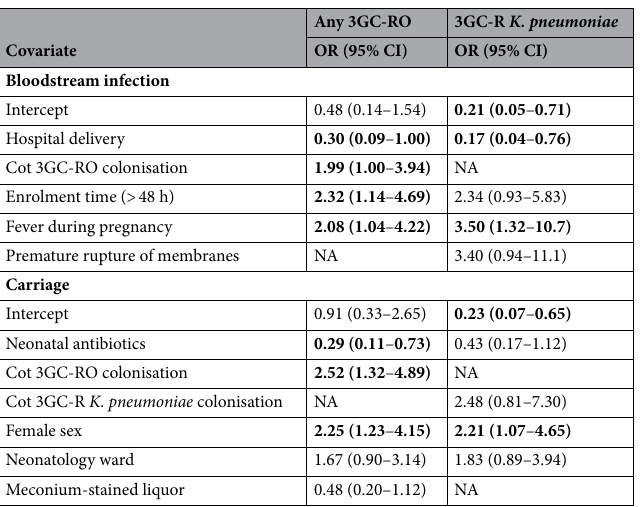
Table 4. Final logistic regression models for neonatal BSI caused by and carriage of all 3GC-RO and 3GC-R K. pneumoniae only. Odds ratios shown with 95% confidence interval. Significant associations are shown in bold. PROM premature rupture of membranes, 3GC-RO third-generation cephalosporin resistant organism, NA not